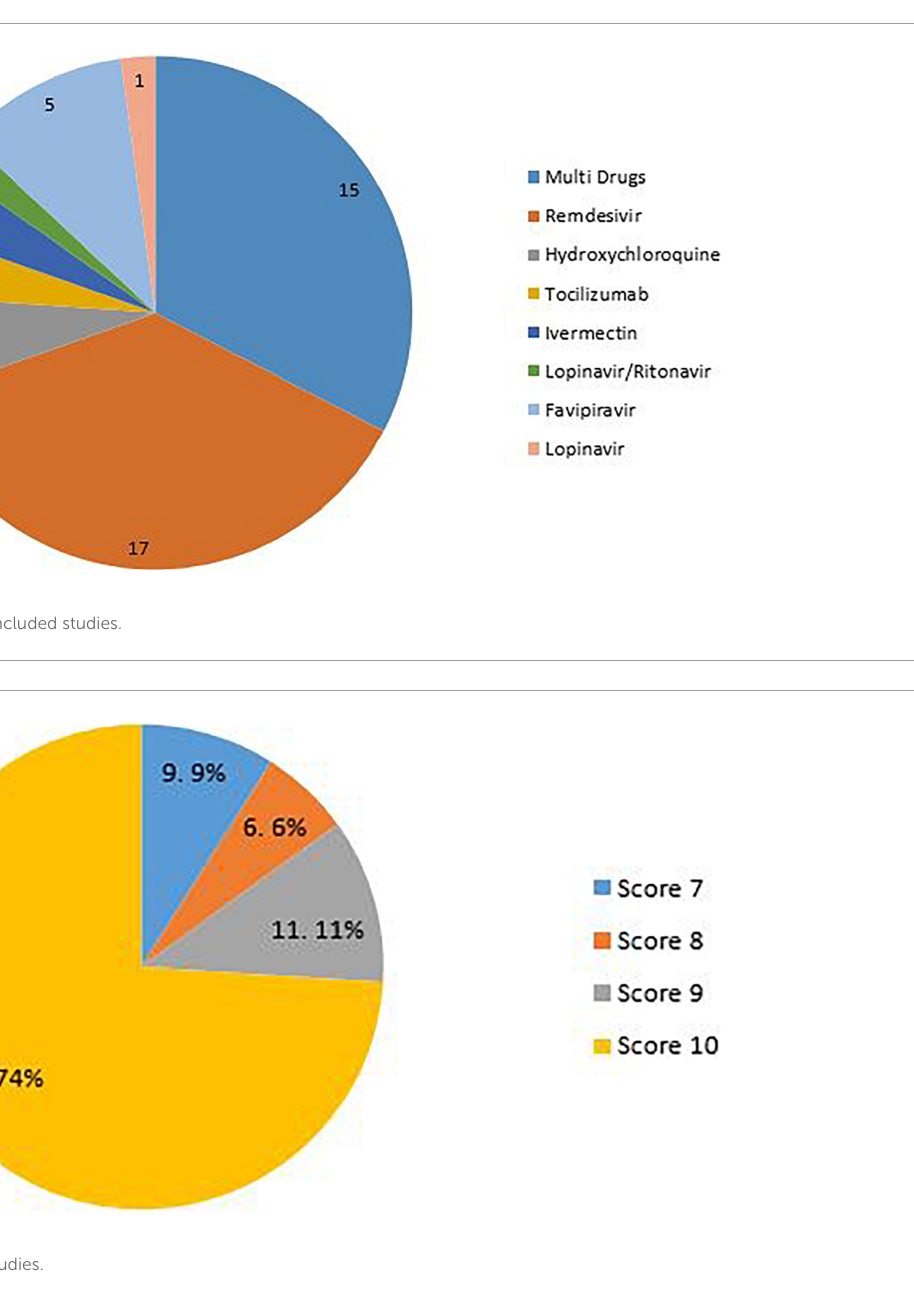
FIGURE4 Quality scores of the included